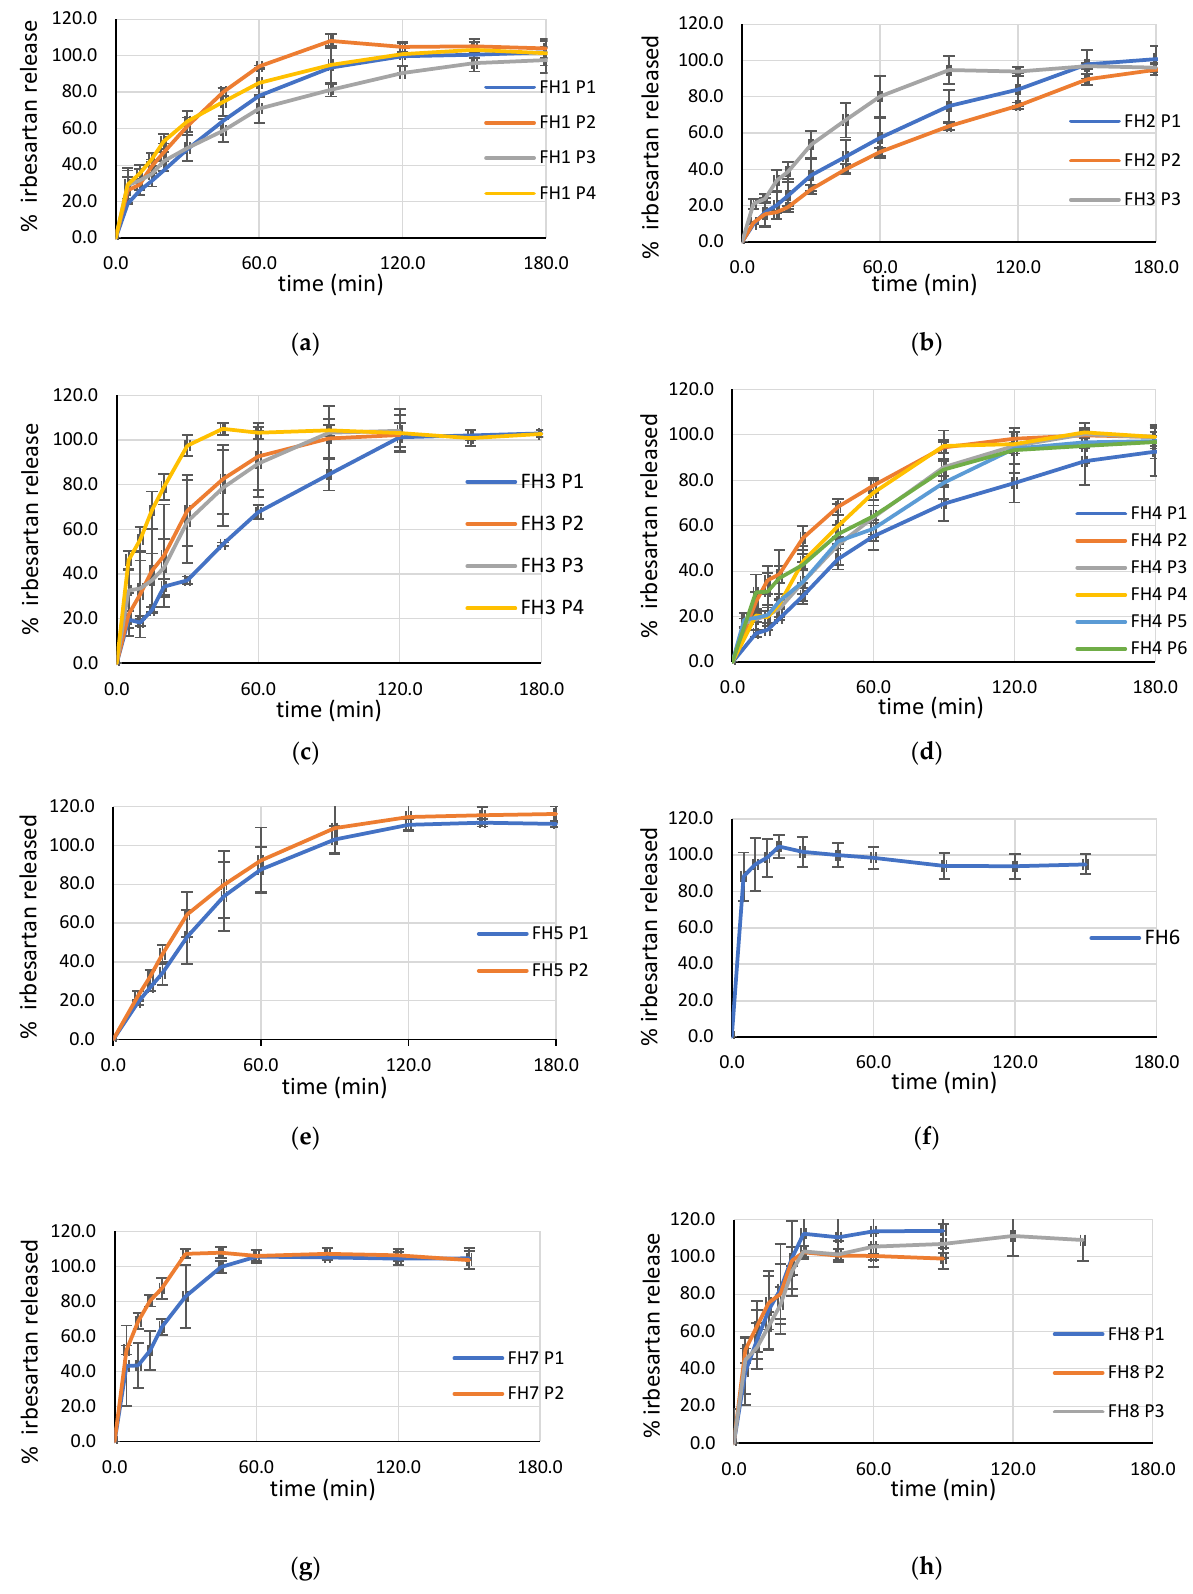
Figure 9. Drug release from irbesartan SLS tablets produced with different laser speeds: P1-100.00 mm/s, P2-120.00 mm/s, P3-140.00 mm/s, P4-160.00 mm/s, P5-180.00 mm/s, and P6-220.00 mm/s; ( a ) FH1, ( b ) FH2, ( c ) FH3, ( d ) FH4, ( e ) FH5, ( f ) FH6, ( g ) FH7, and ( h ) FH8.